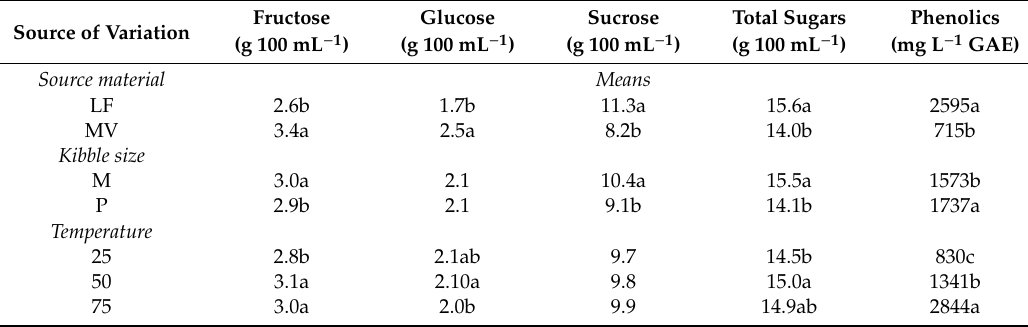
Table 1. Percentage of variance explained by main e ff ects and mean comparisons for fructose (FRU), glucose (GLU), sucrose (SUC), total sugars, and phenolics obtained by conventional extraction (HAE) using two source materials (LF: Lefkaritiki; MV: Mavroteratsia) and two kibble sizes (M: medium-size kibbles; P: powder-size kibbles) in a range of extraction temperatures (25, 50, and 75 ◦ C) and durations (80, 160, 240, 320 min). GAE: gallic acid equivalents. Interaction plots of main e ff ects on sugars and phenolics are presented separately in Figure